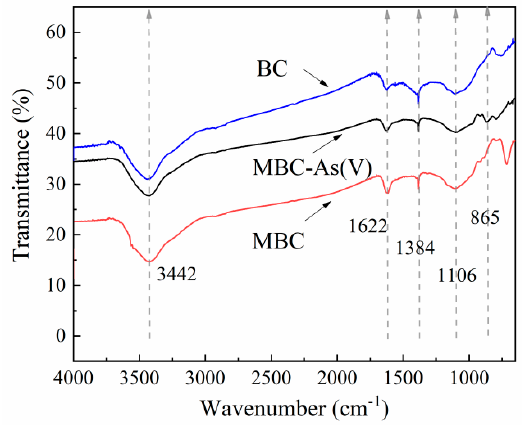
Figure 2. FT-IR spectra of BC, MBC (before adsorption) and MBC-As(V) (after adsorption).